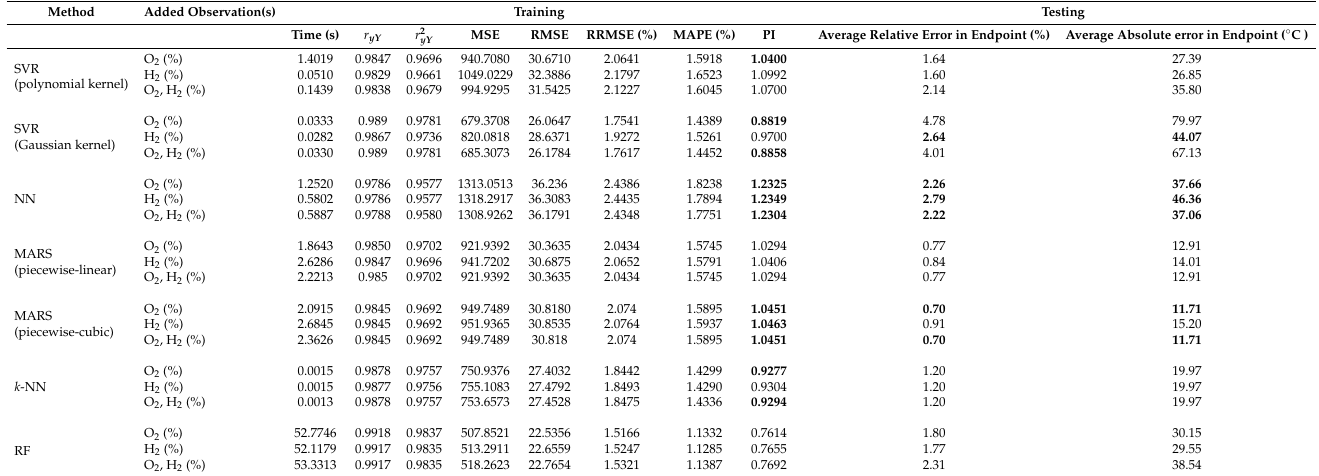
Table 19. Performance of machine learning and temperature prediction based on dynamic data (concentration of O 2 and H 2 added as supplementary observations).